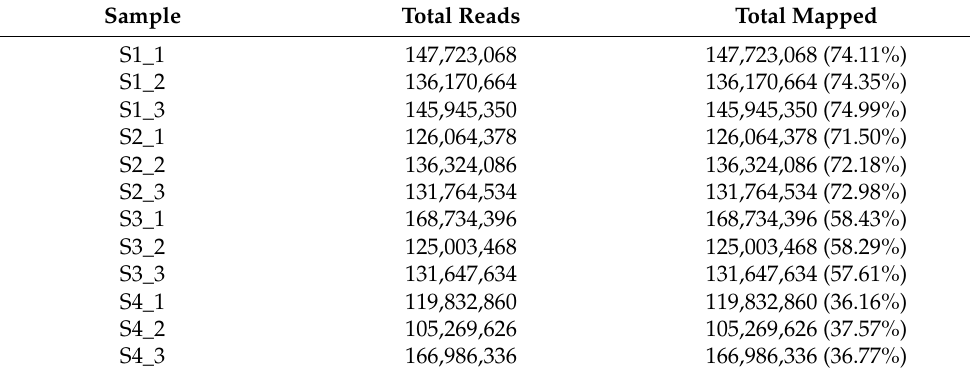
Table 3. Results of clean reads alignment B. pervariabilis × D. grandis in dual RNA-seq